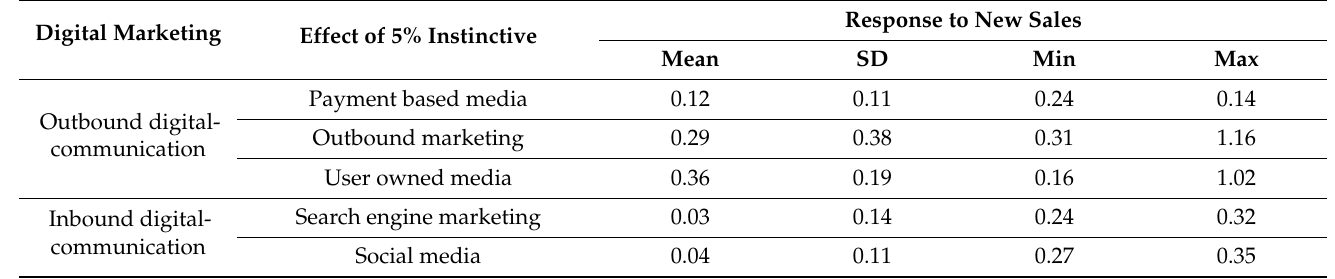
Table A1. Average collective elasticities of digital media on multiple response variables and